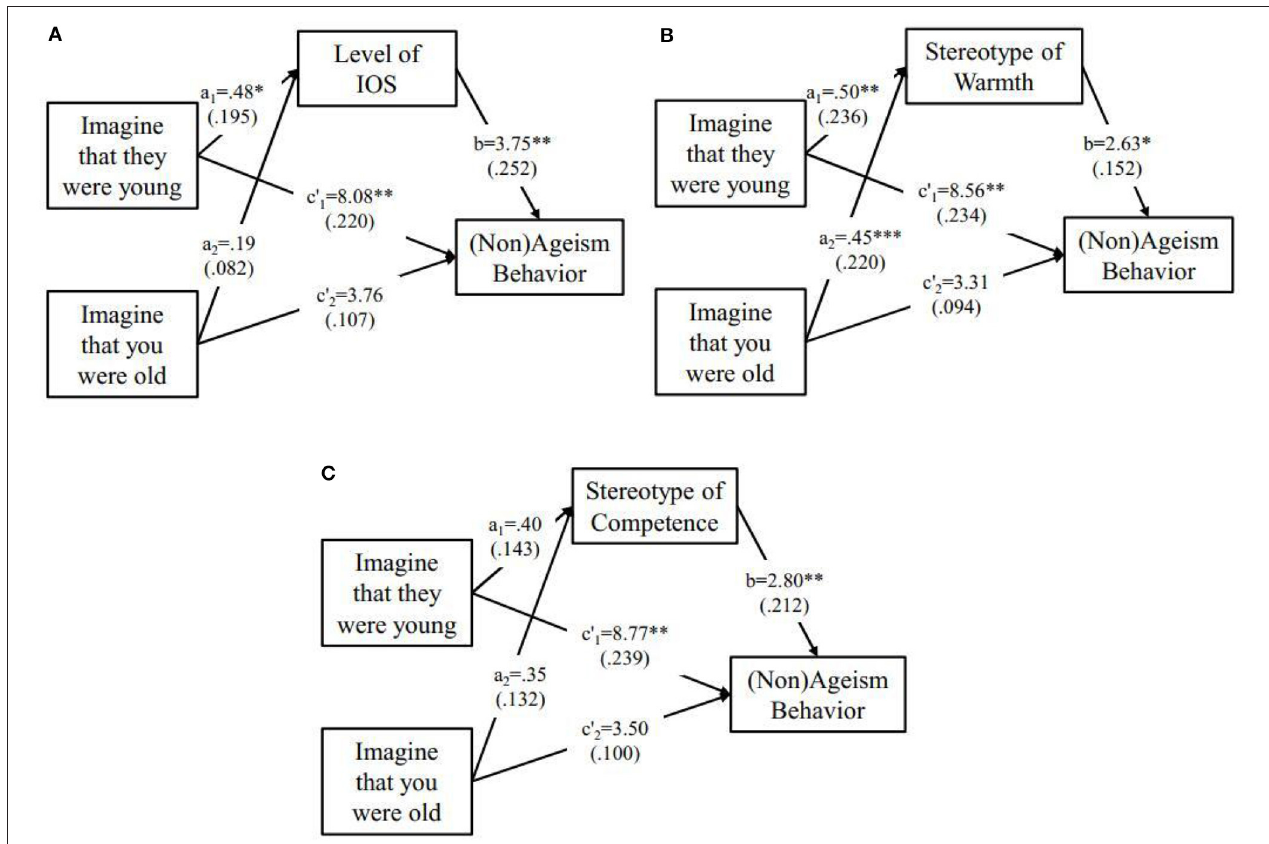
FIGURE 3 | Relative mediation model of warmth (A) , level of IOS (B) , and competence (C) on effect of interventions (compared with control condition) to (Non)hostile ageism behaviors, for which was measured as medical funds allocated to older adults . Standardized path coefficients were presented in parentheses. *p < 0.05; **p < 0.01; ***p <